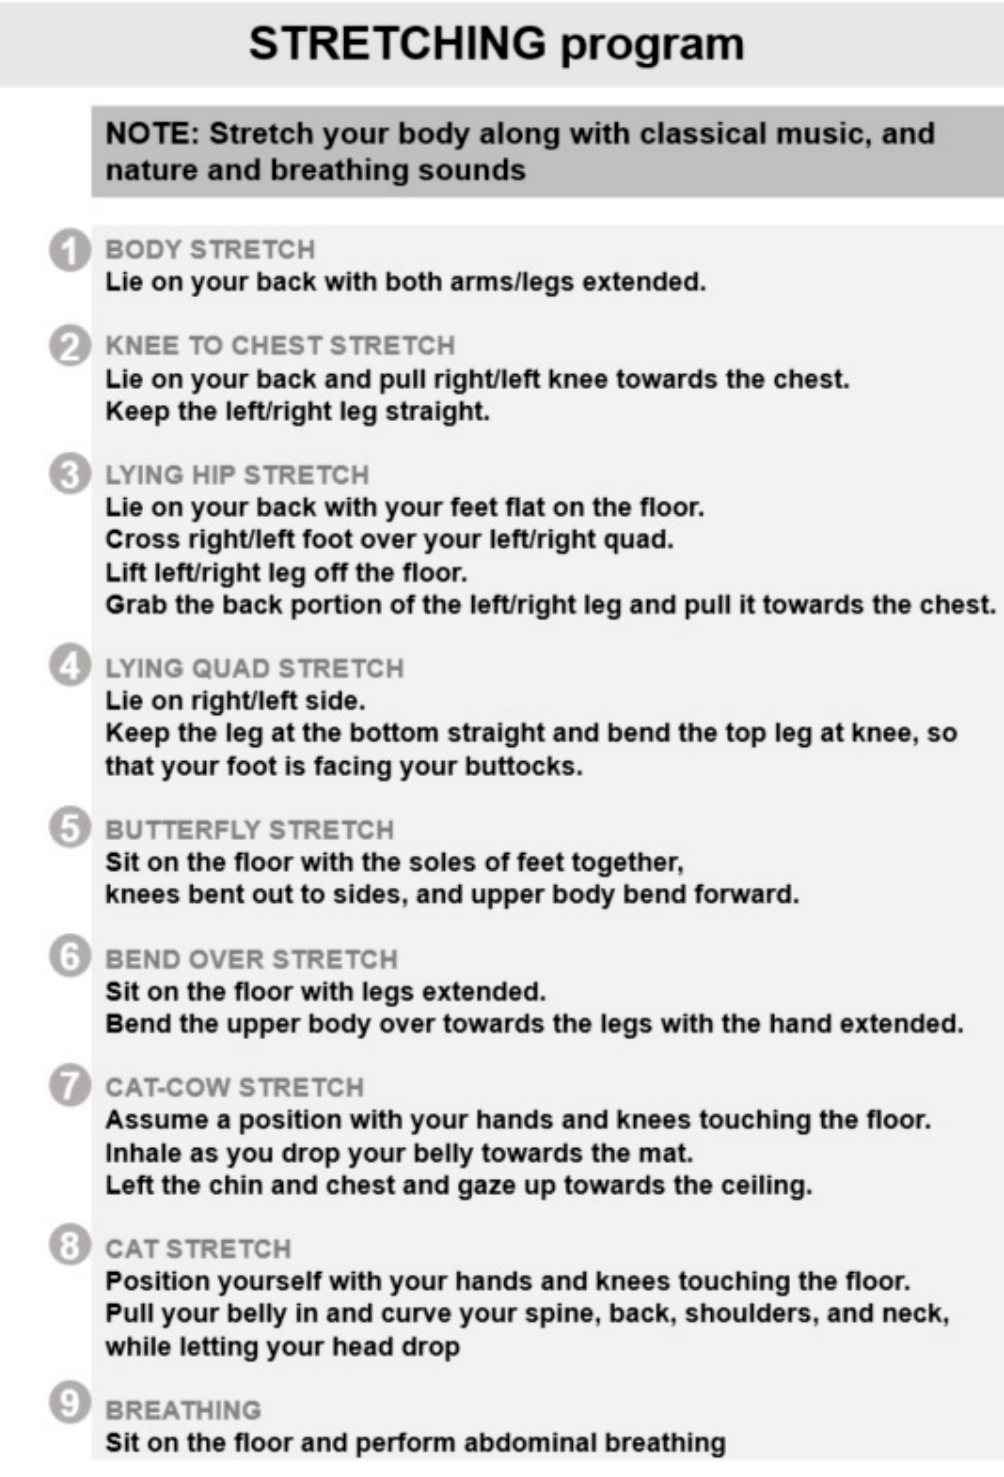
Figure A27. Detailed description of movements performed in the stretching program.